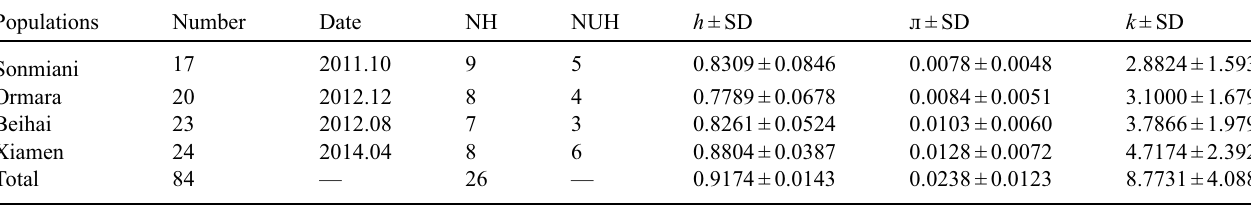
Table 1. Summary statistics for mtDNA molecular indices of P. chinensis.